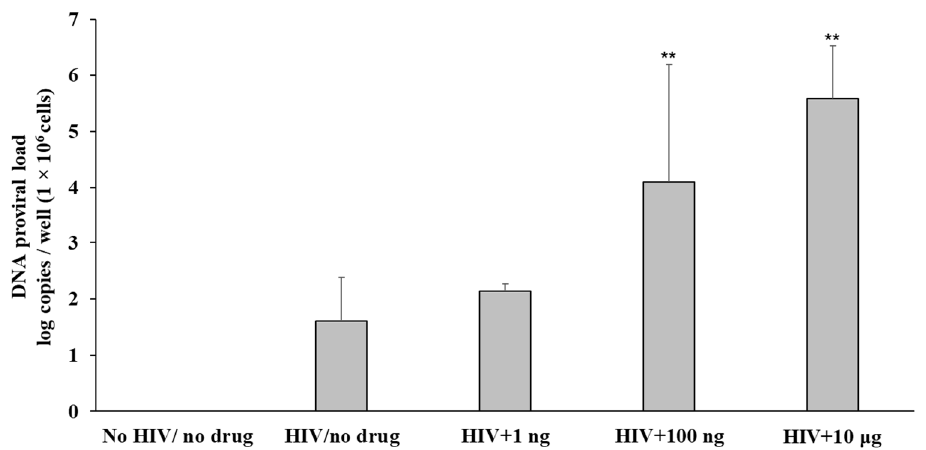
Figure 4. TZM-bl cells were seeded at a density of ~1 × 10 6 cells per well. After 24 h, cells were treated with HIV NL4-3 for 1 h at TCID 50 of 0.5, rinsed with PBS three times to remove any unbound virus, and replaced with fresh media. Fentanyl at varying concentrations was added to the respective wells and incubated. After incubation with the drug for 24 h, HIV proviral DNA was quanti fi ed in cells with real-time PCR based on SYBR Green detection. Error bars represent the standard deviations between the replicates. ANOVA for dose e ff ect: p = 0.0006. ** p < 0.01.